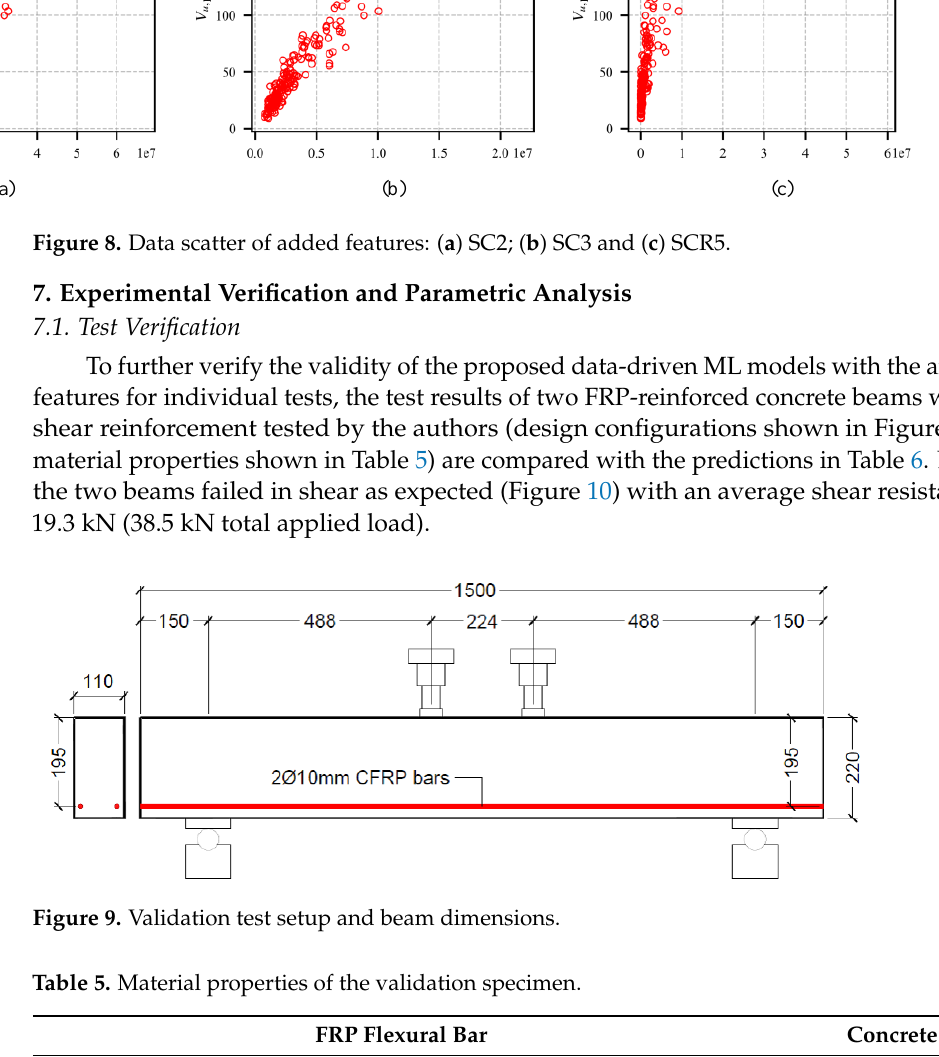
Figure 8. Data scatter of added features: ( a ) SC2; ( b ) SC3 and ( c ) SCR5.